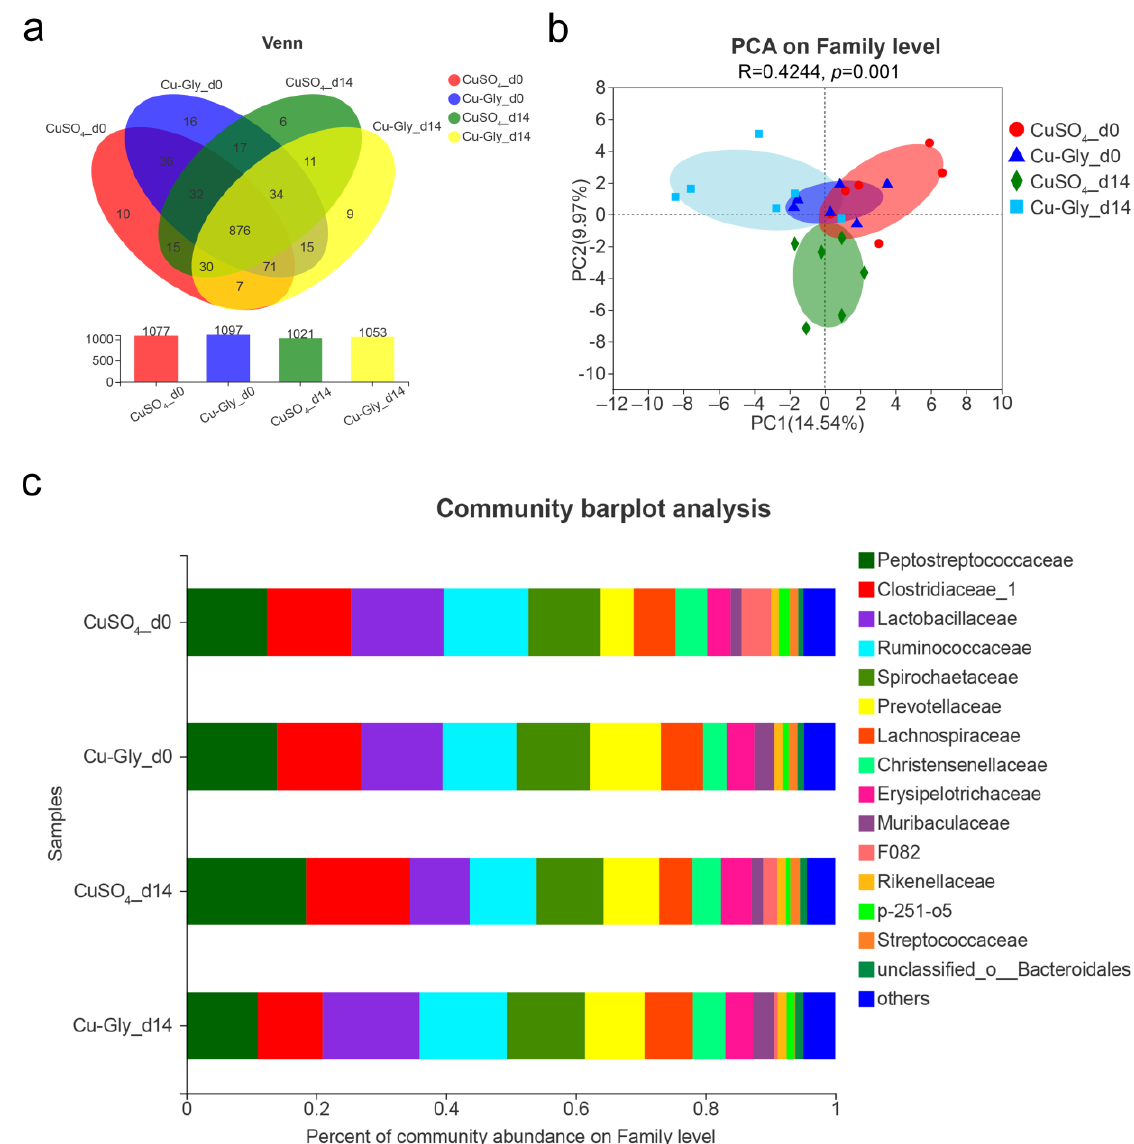
Figure 3. Changes in microbial communities in the feces of pigs. ( a ) Venn analysis at the OTU level; ( b ) Principal component analysis (PCA) score plots at the family level; ( c ) Taxonomic classification of the 16S rRNA gene sequences at the family level. n = 6.